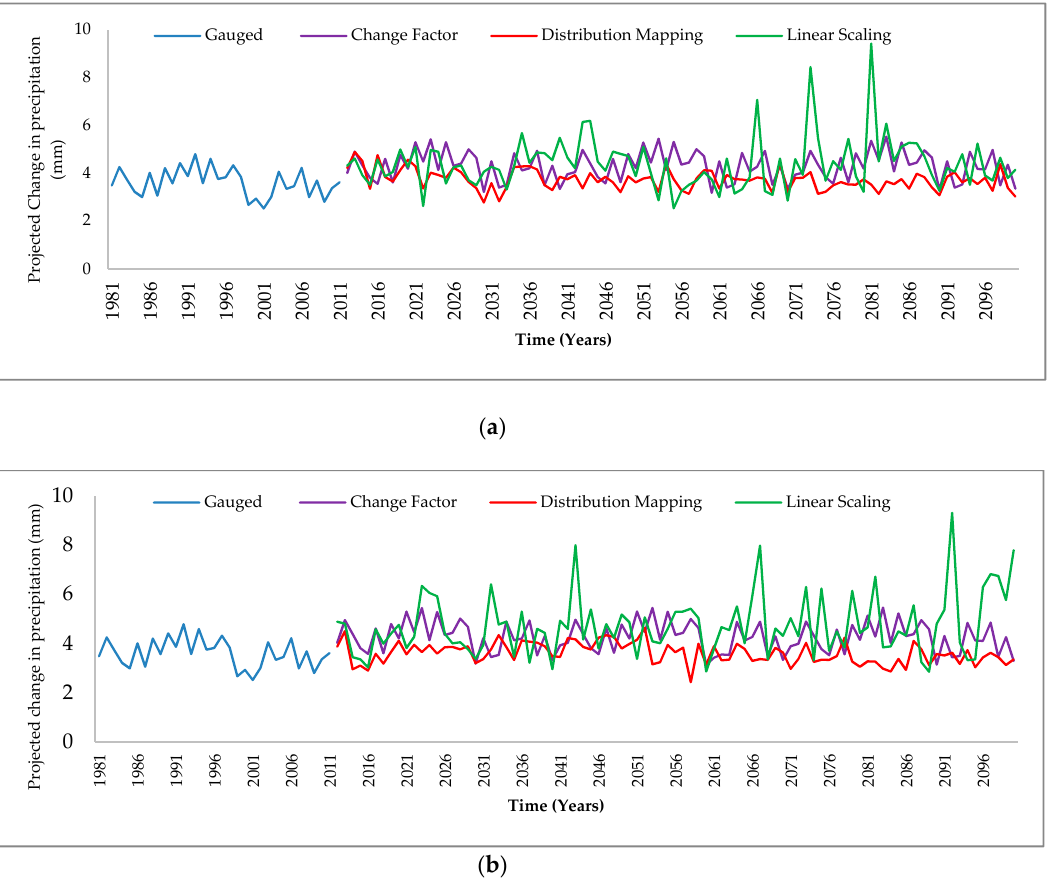
Figure 9. GCMs model ensembled average annual precipitation change from 1981 to 2100 under three downscaling techniques. ( a ) RCP 4.5, ( b ) RCP 8.5.